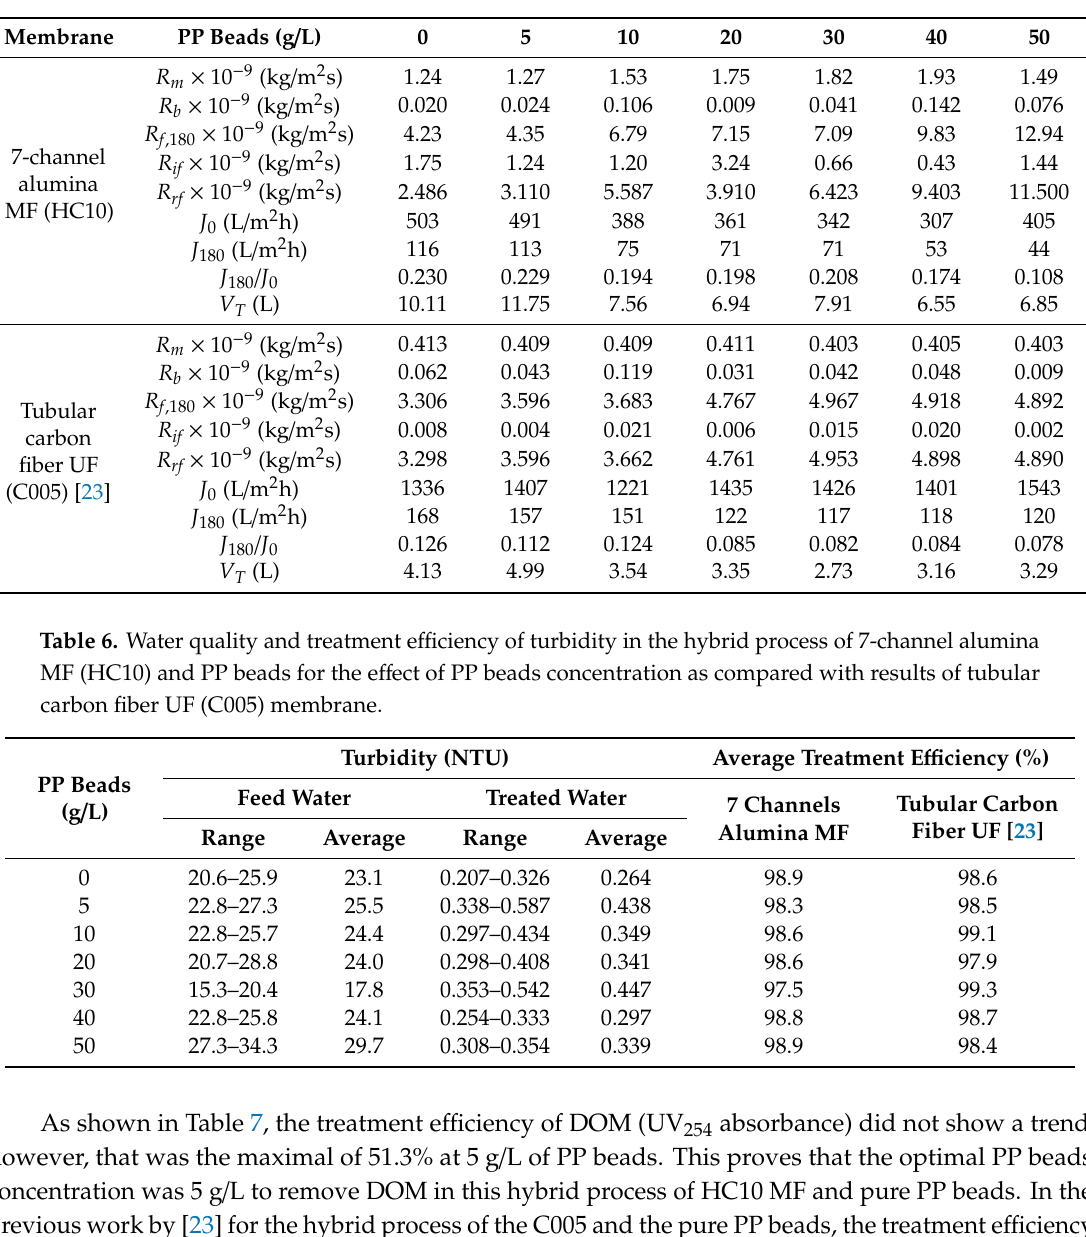
Table 5. E ff ect of PP beads concentration on filtration factors in the hybrid process of 7-channel alumina MF (HC10) membrane and PP beads with periodic water backwashing (BT 10 s, FT 10 min) as compared with the results of tubular carbon fiber UF (C005) membrane.